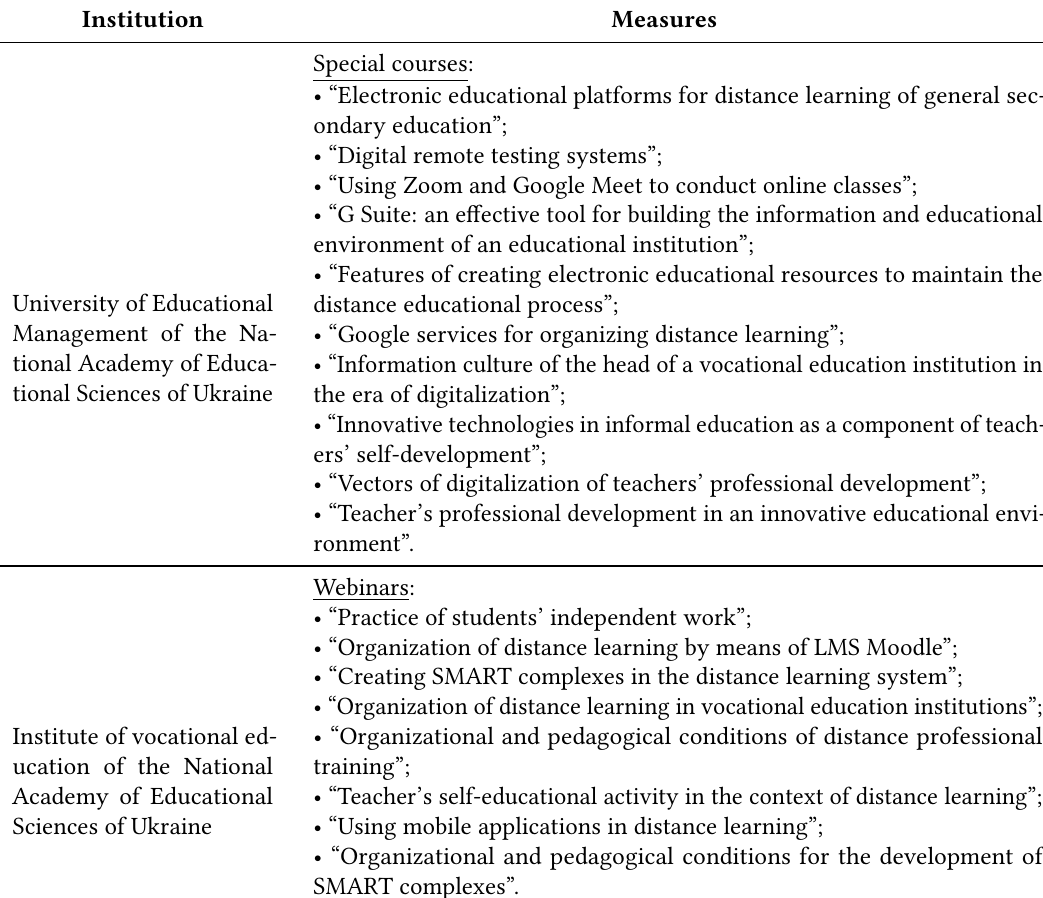
Table 3 Special measures to improve the level of teachers’ digital